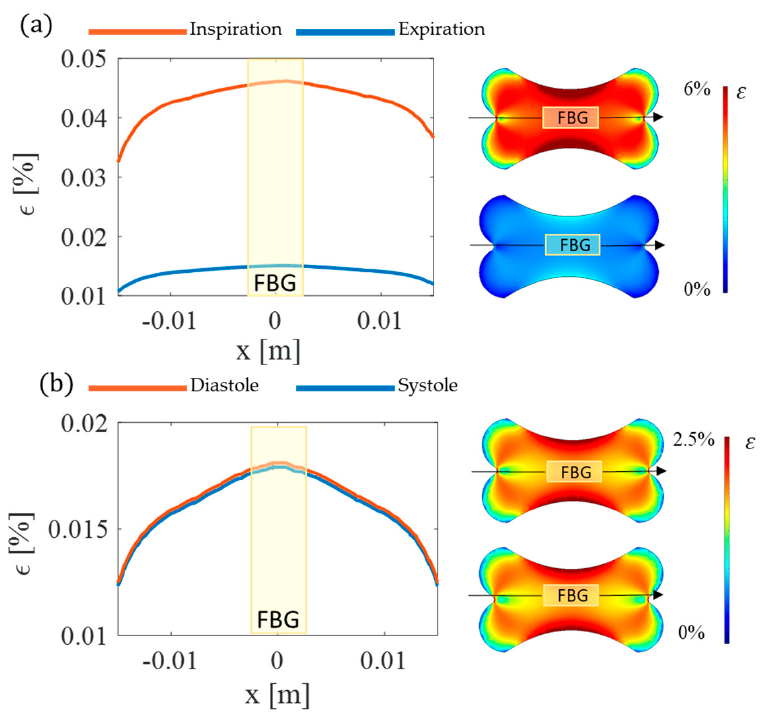
Figure 4. Summary of computational studies highlighting ( a ) the effects of breathing (blue line refers to inspiration and orange line to expiration) and ( b ) the effects of heart beating (blue line refers to systole and orange line to diastole) on the optical fiber and the FBG sensor.